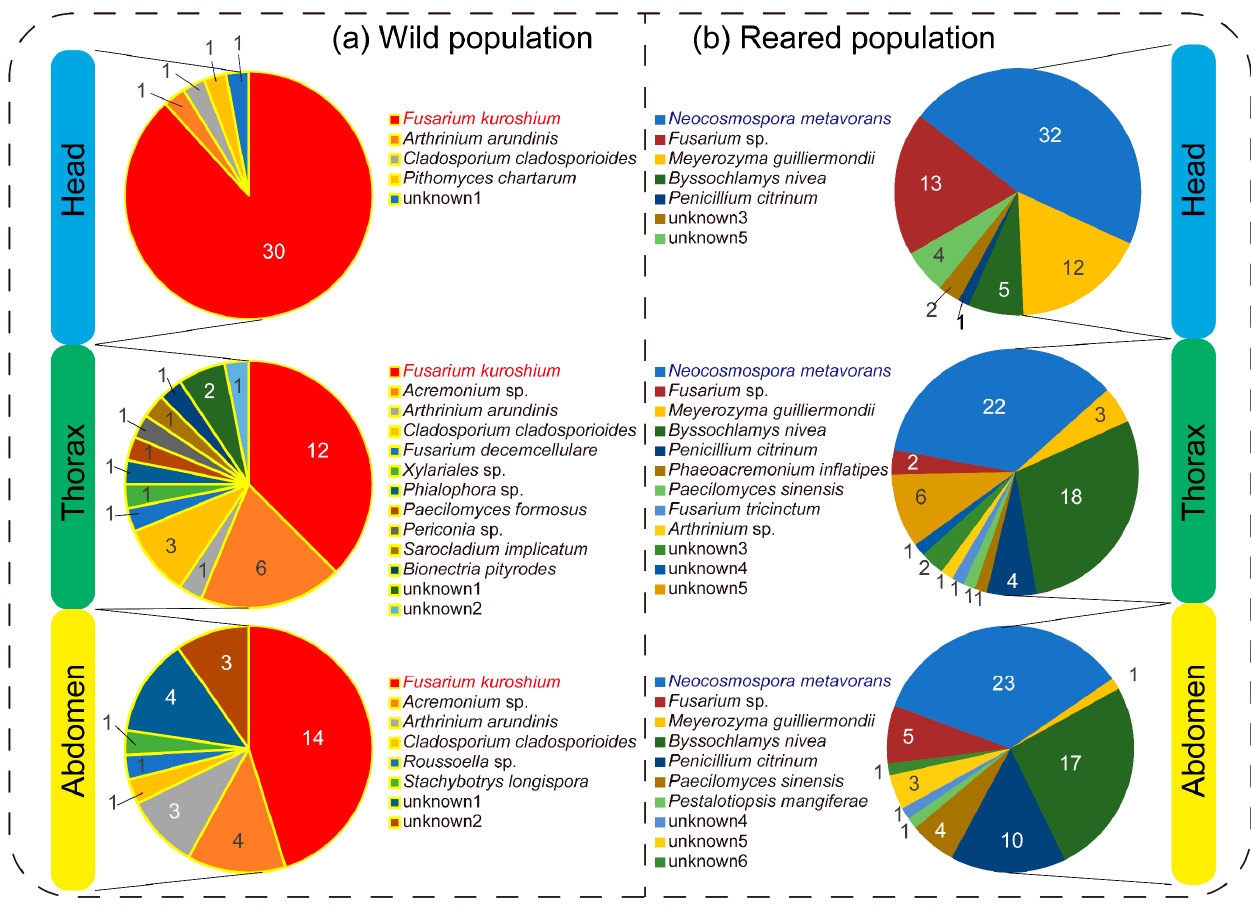
Figure 5. Comparison of fungal flora and their relative dominance in female adults of Euwallacea interjectus among wild (( a ): 51 beetles) [34] and reared (( b ): 54 beetles) populations (Table 1). Num- bers of beetles from which each fungal species was isolated is shown in pie